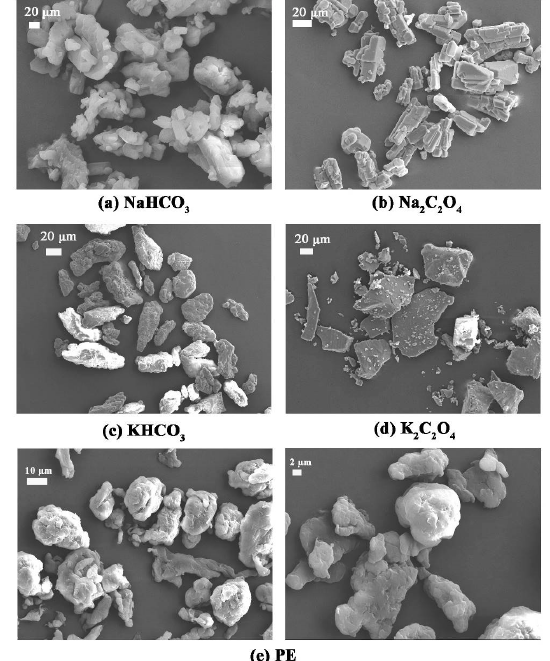
Figure 4. SEM images of different dust particles.